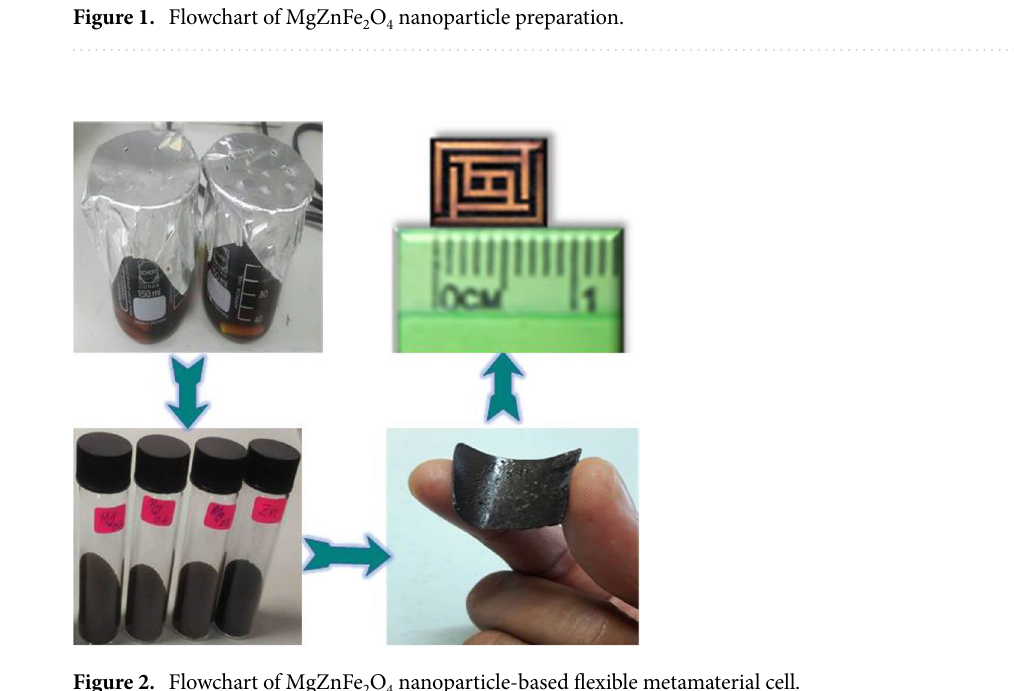
Figure 2. Flowchart of MgZnFe 2 O 4 nanoparticle-based flexible metamaterial